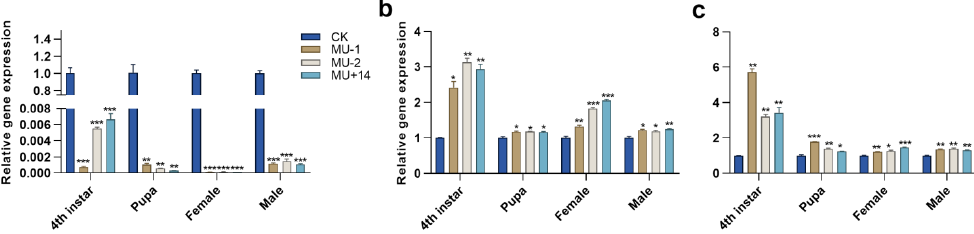
Figure 5. Effects of Pxtret1-like knockout on the expression of TPS and TRE in Plutella xylostella at different developmental stages. ( a ) The expression of TPS ; ( b ) the expression of TRE1-1 ; ( c ) the expression of TRE1-2. CK: wild-type strain; MU-1: PxTret1-like -1bp mutant; MU-2: PxTret1-like -2bp mutant; MU+14: PxTret1-like+ 14bp mutant. Error bars represent standard error of the mean. An ndependent-samples T-test was used. * indicates p < 0.05; ** indicates p < 0.01; *** indicates p < 0.001.